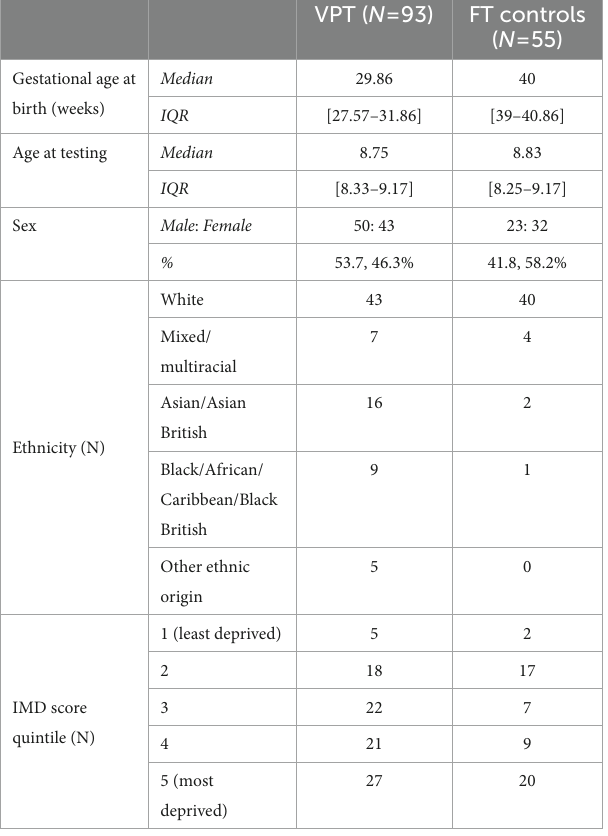
TABLE 1 Socio-demographic and clinical charactersitics of the study sample. VPT ( N = 93) FT controls ( N =